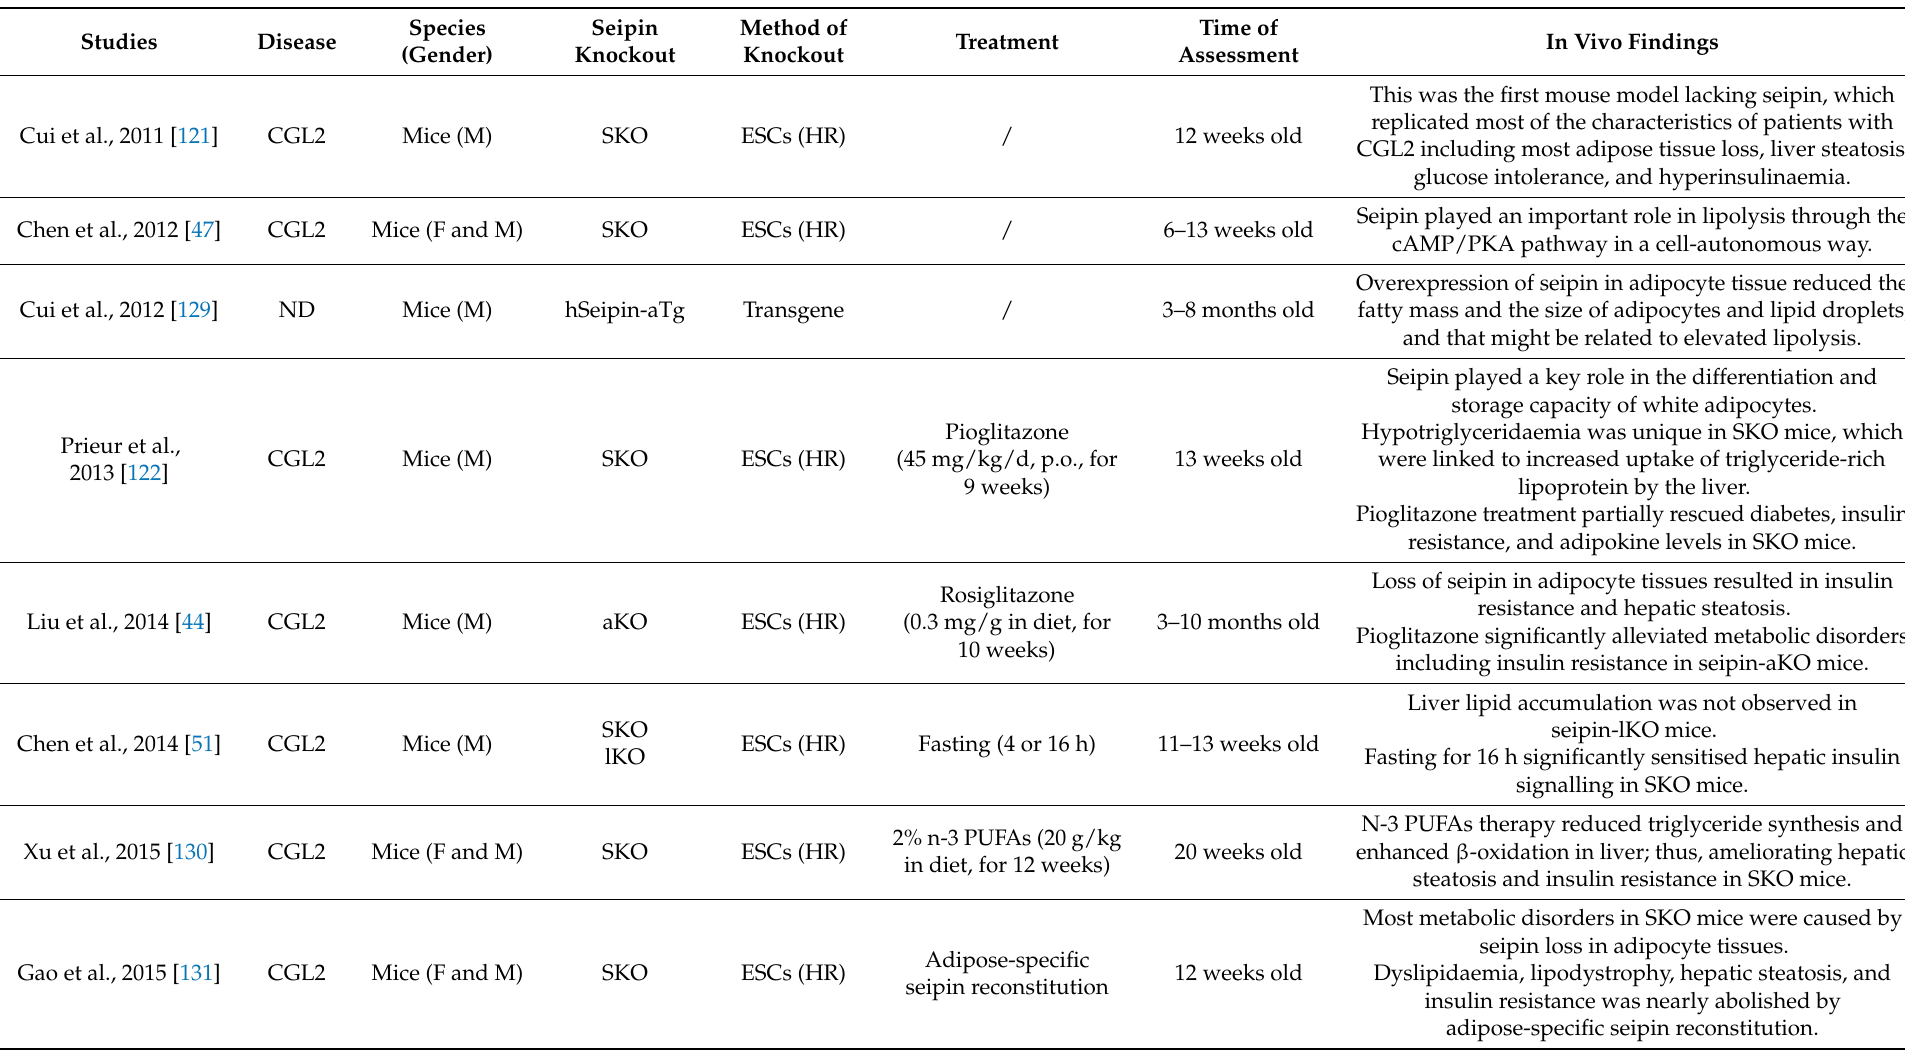
Table 4. Metabolic disorders of seipin deficiency or overexpression in